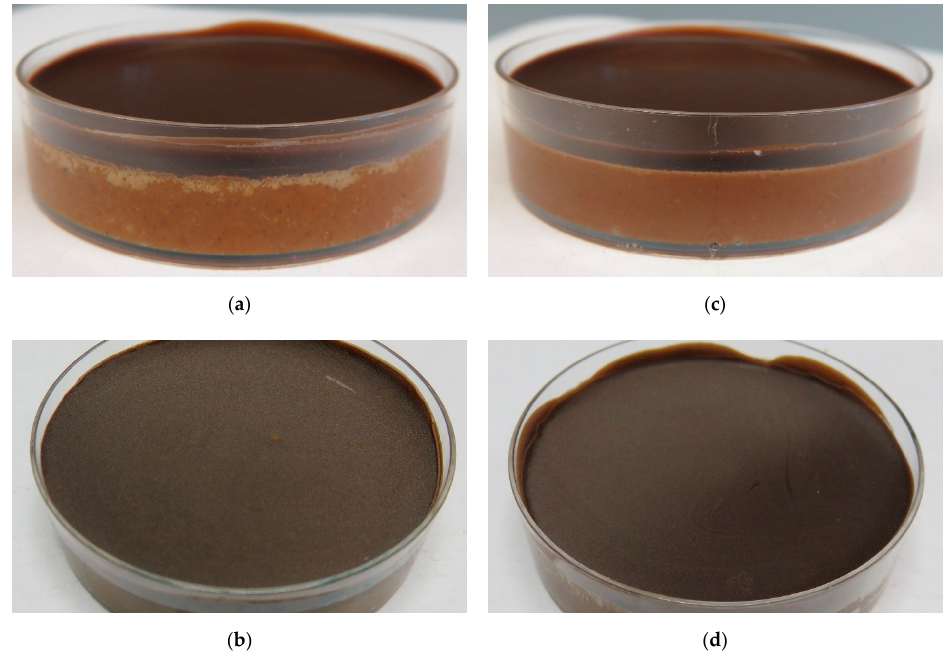
Figure 5. Layer models after 28 days storage at 23 °C showing enhanced fat bloom at the interface between nougat and chocolate ( a ) and at the chocolate surface ( b ), and corresponding systems with nougat #A seeded with 1% cocoa butter crystals: interface between nougat and chocolate ( c ) and chocolate surface ( d ).